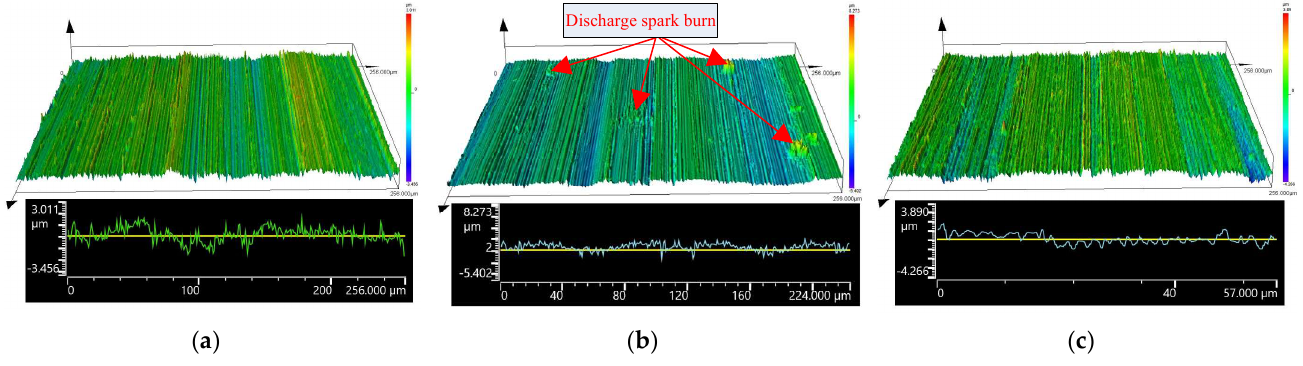
Figure 13. Comparison of machined-surface roughness under the three processing conditions: ( a ) internal cylindrical ordinary grinding; ( b ) internal cylindrical ECG; ( c ) ICUAECG.